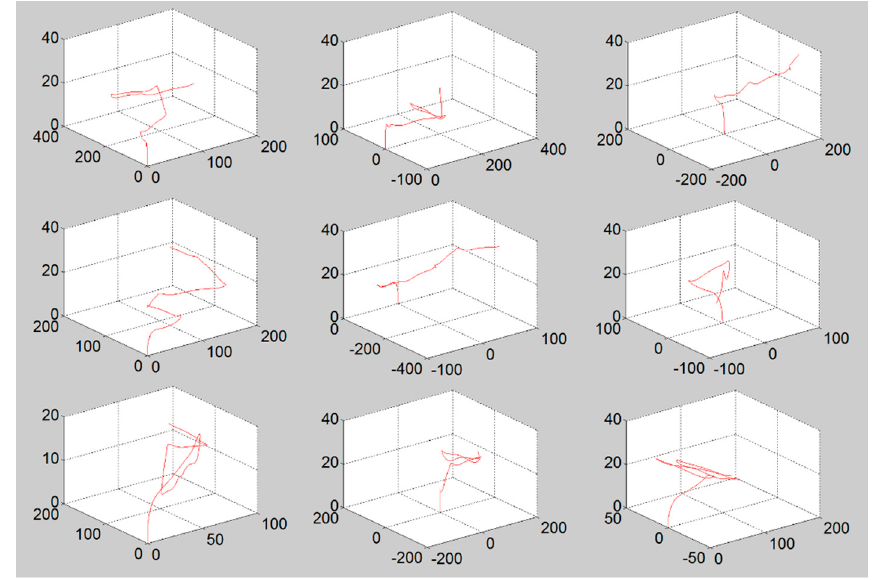
Figure 4. Examples of arbitrary flight patterns generated by Robotics Toolbox. (x, y, z in meters).